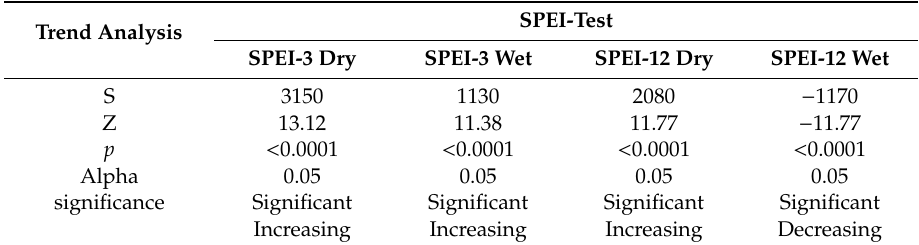
Figure 3. Evolution of the mean SPEI for 3- and 12-month timescales for moderate, severe, and extreme drought and flood over Kenya showing the variation in the duration, severity, and intensity of dry and wet events, 1981–2016. Table 1. Summary of Mann–Kendall test statistic for SPEI-3 and SPEI-12 over Kenya at the 5% significance level.